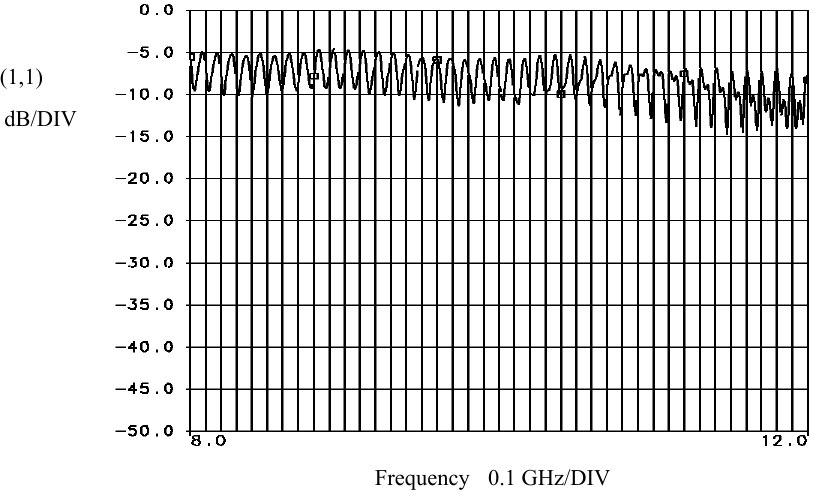
Figure 7. Experimental measurements of reflection coefficient in dB vs frequency with the glass (mosaic) layer.